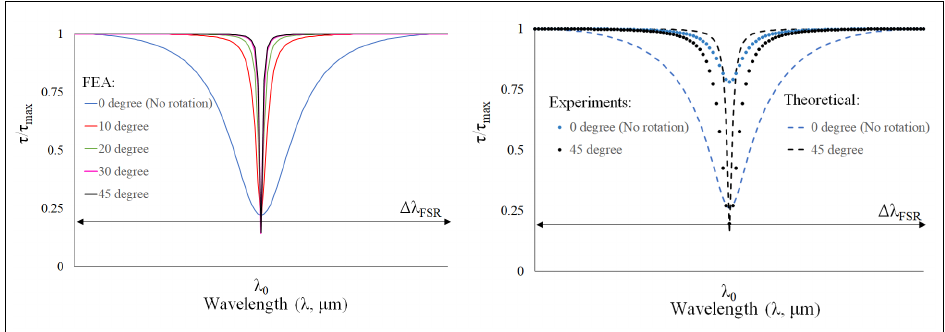
Figure 13. Comparison of the optical response of the on-chip RCSS device with different angles of rotations: ( left ) FEA method, ( right ) optical experiments, and theoretical modeling. Here, R c = 50 µ m, and the total optical path length is 400 µ m, TE